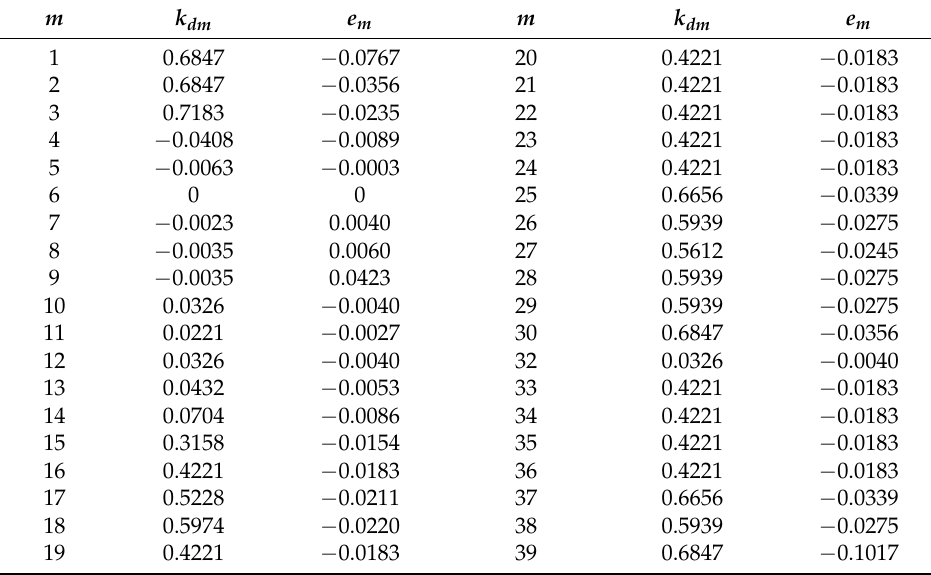
Table 1. Results of k dm and e m for scenario 1.